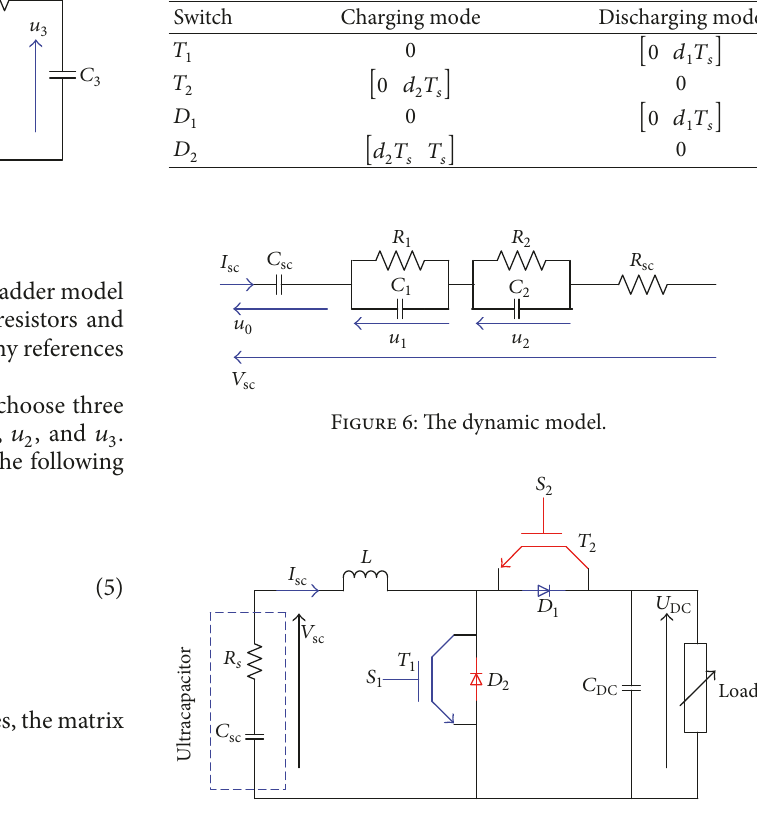
Figure 7: Topology of DC-DC